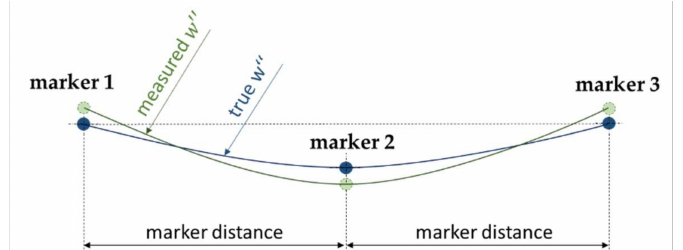
Figure 4. Schematic drawing at data frame i with the true marker positions in blue and the detected marker positions from Qualisys in green. Three markers define a circle with the corresponding curvature. The true w (cid:48)(cid:48) of the blue curve minus the measured w (cid:48)(cid:48) of the green curve gives the difference (in mm − 1 ) at data frame i.